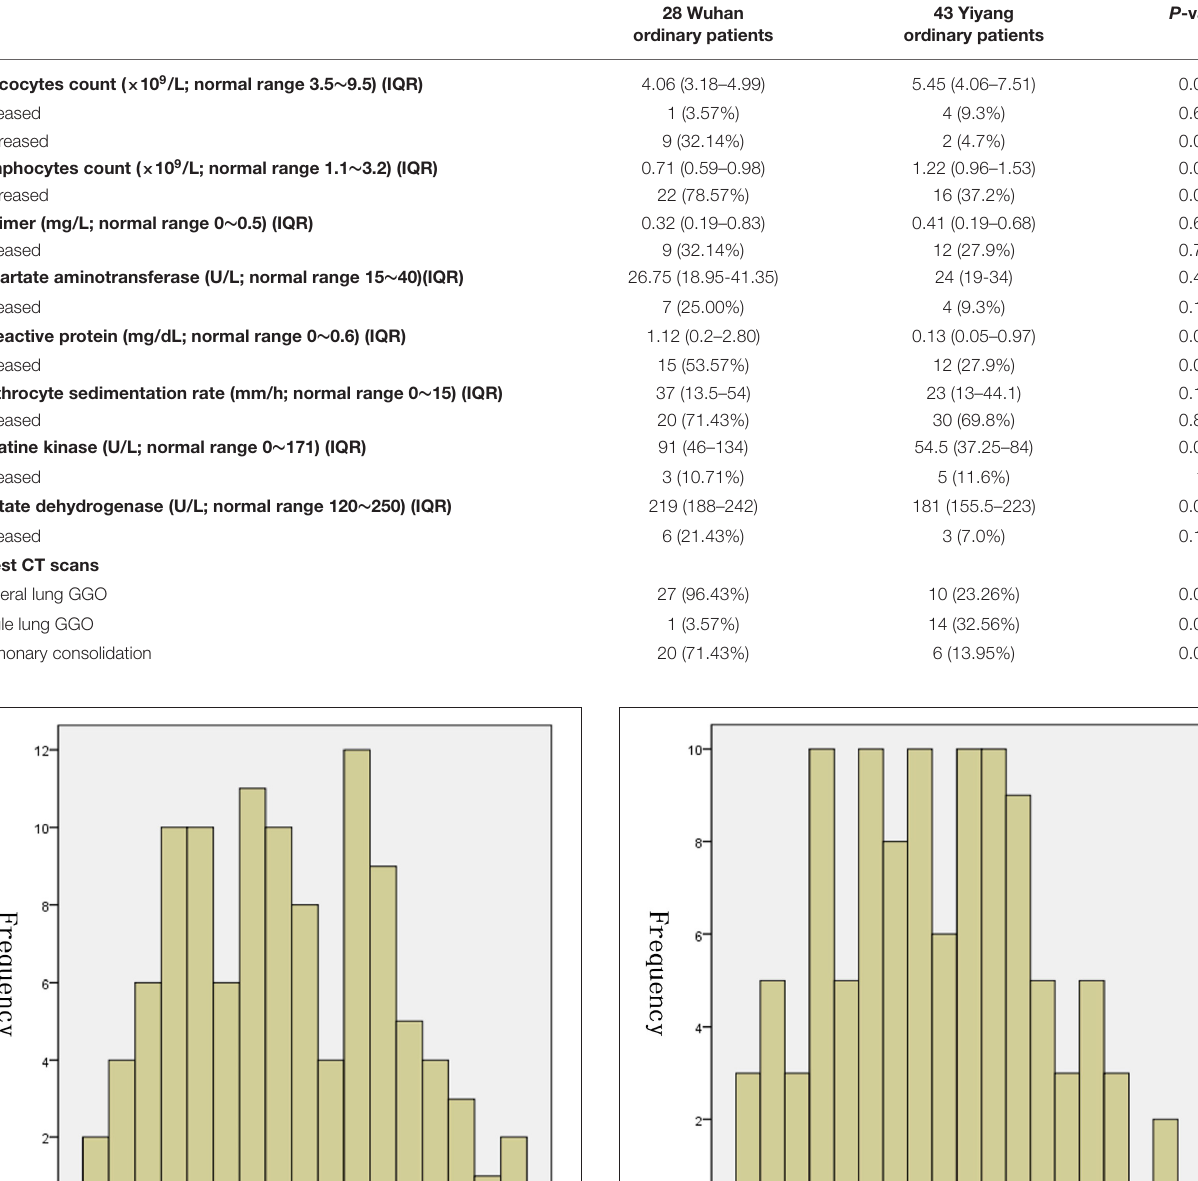
TABLE 4 | Laboratory examination of ordinary patients with moderate-type COVID-19 from Wuhan and Yiyang.